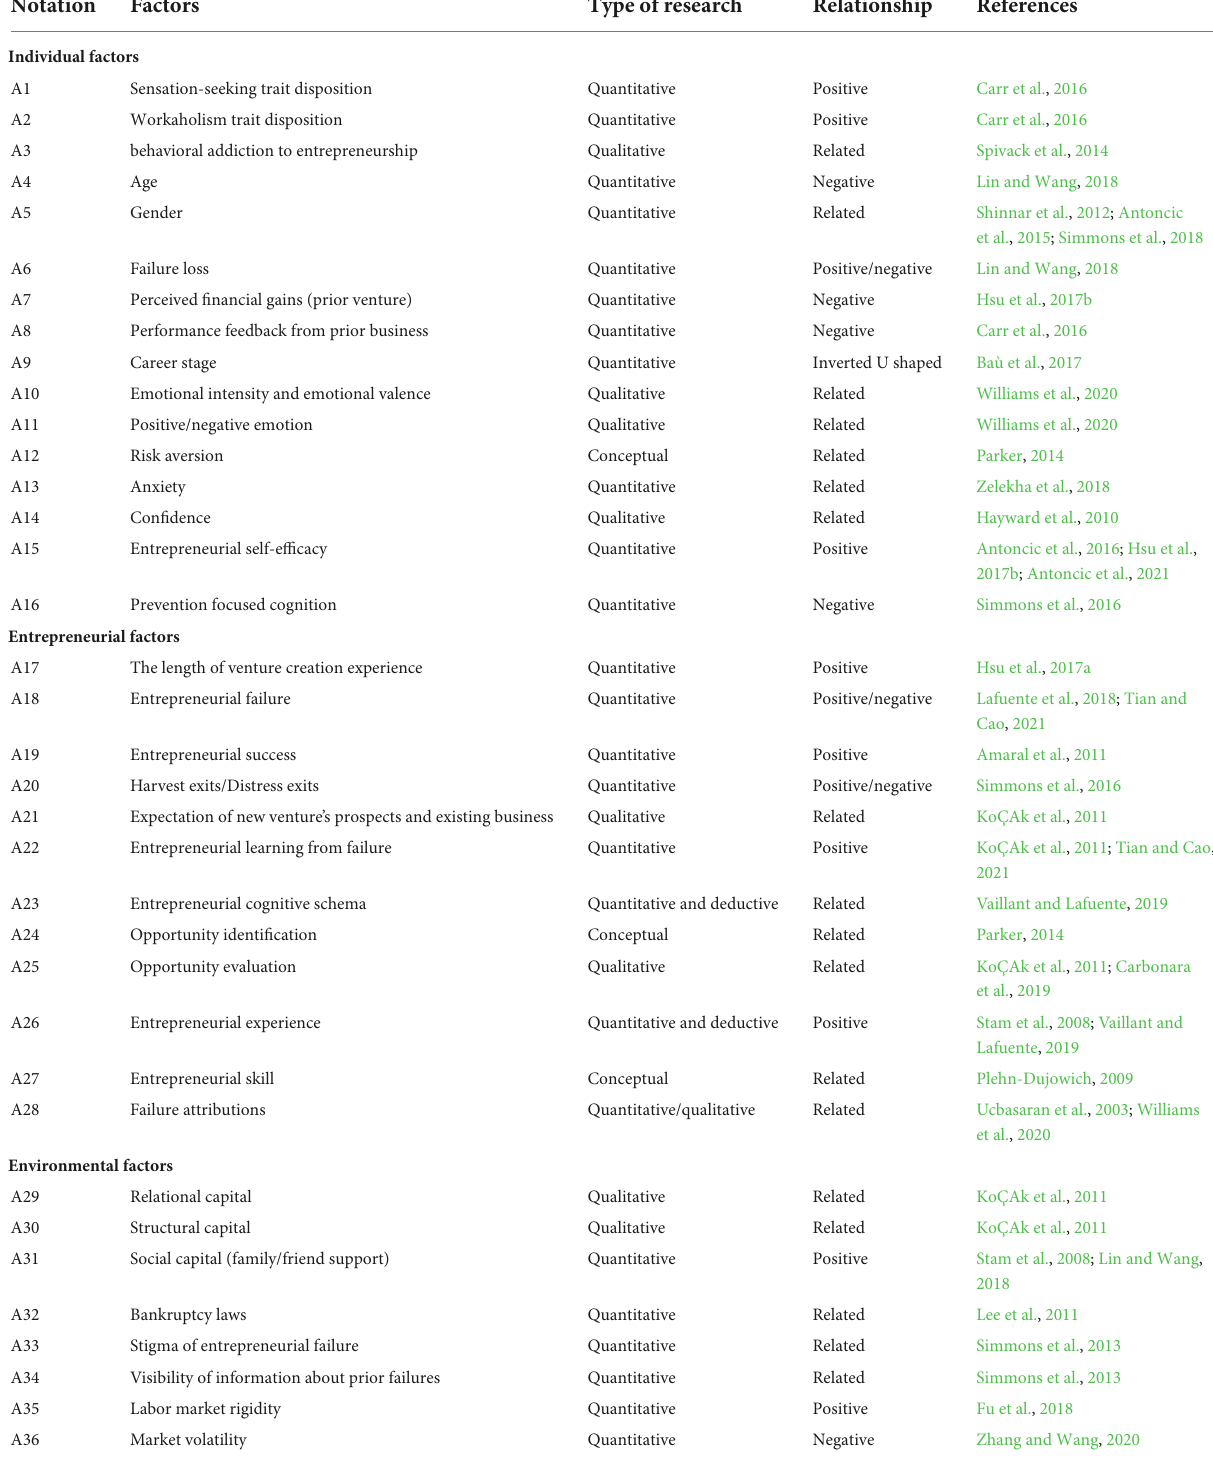
TABLE 1 Identified factors of serial entrepreneurial